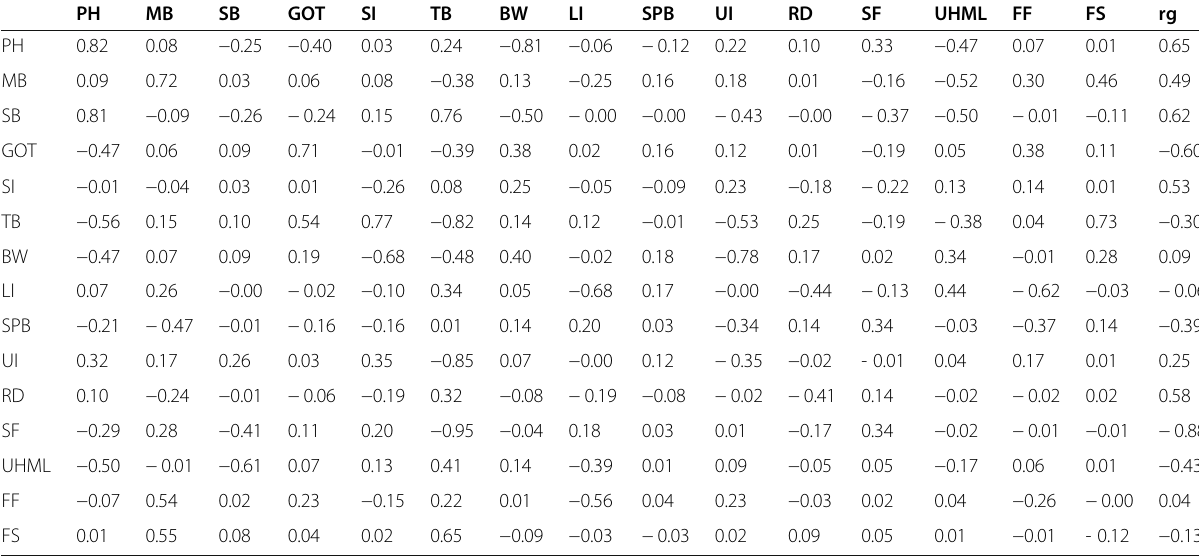
Table 7 Direct and Indirect effects for various yield and quality-related traits in upland